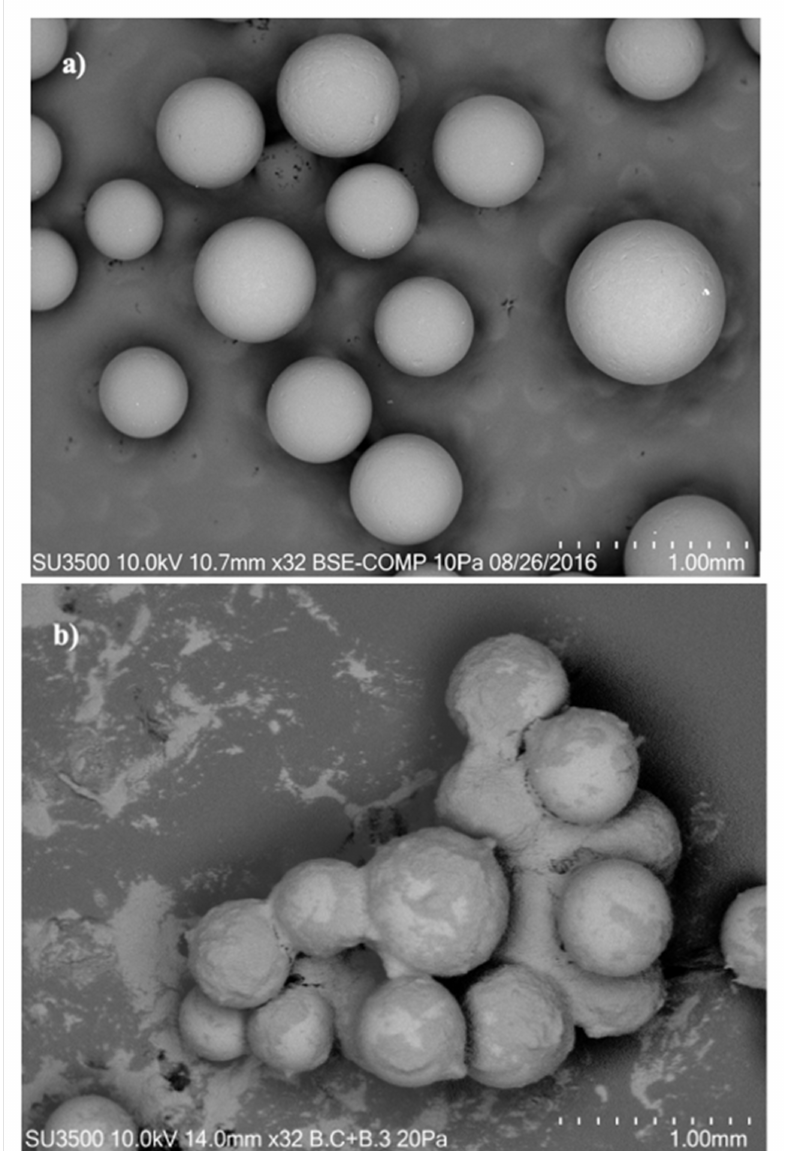
Figure 6. Scanning electronic microscopy (SEM) images of the resin before and after the cadmium adsorption from the GSH solution. ( a ) Resin in the original state and ( b ) resin from a saturated column. The cadmium concentration of the liquid GSH was 20.97 mg L − 1